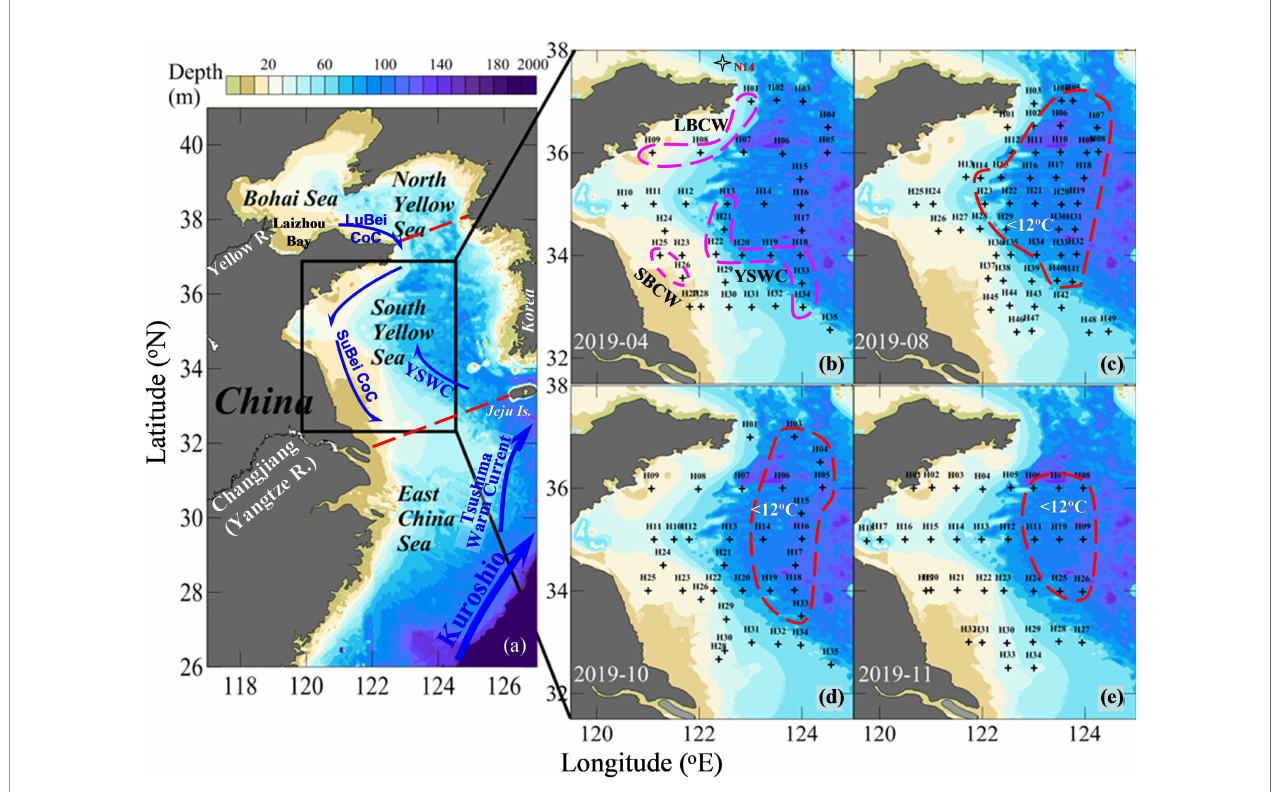
FIGURE 1 | Study area and sampling sites during seasonal mapping cruises in 2019. In (A) , Kuroshio Current, Tsushima Warm Current, YSWC, Subei Coastal Current (SuBei CoC), and Lubei Coastal Current (LuBei CoC) in winter and early spring are sketched. In panel (B) , several typical water endmembers are highlighted based on our fi eld data, including YSWC water, SuBei Coastal Water (SBCW), and LuBei Coastal Water (LBCW). In panels (C – E) , stations with a bottom-water temperature below 12°C are clustered, showing the area of the South Yellow Sea cold water mass (SYSCWM) under